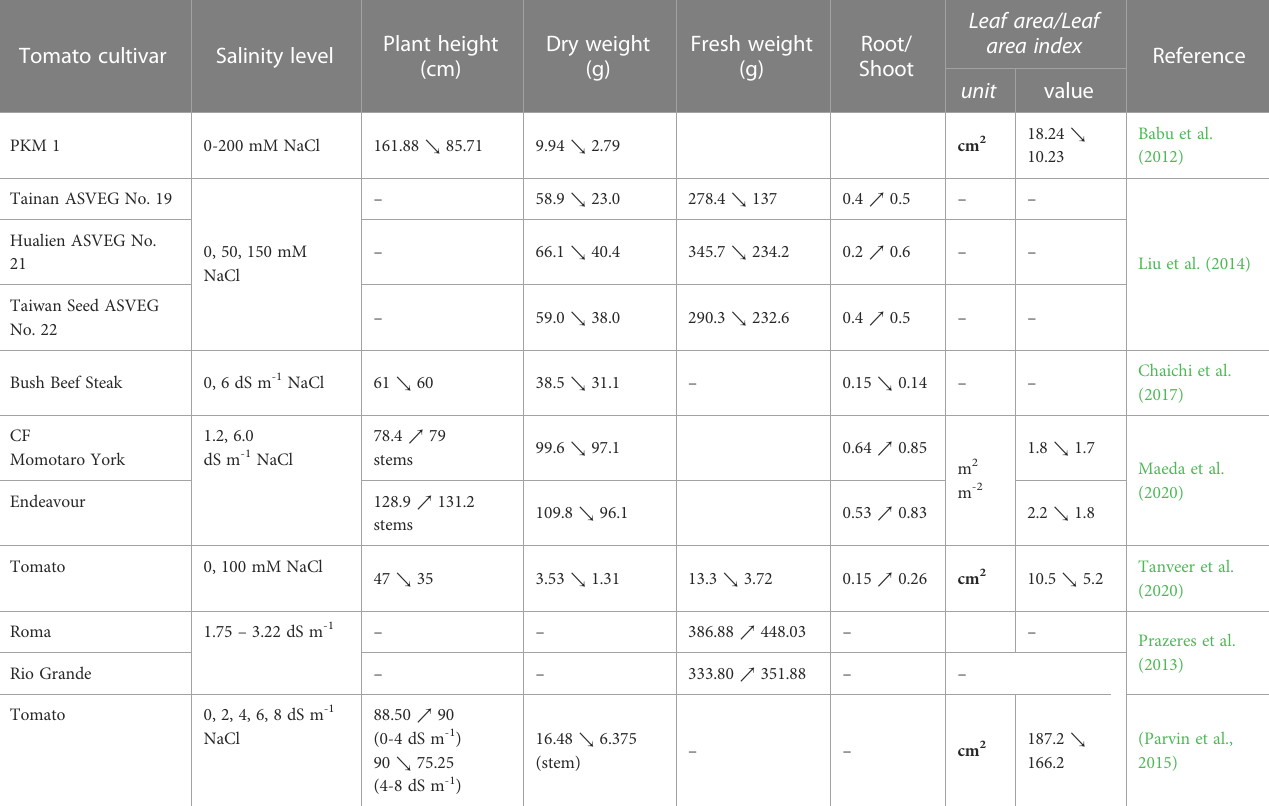
TABLE 1 Morphological changes in tomato plants under salinity stress.